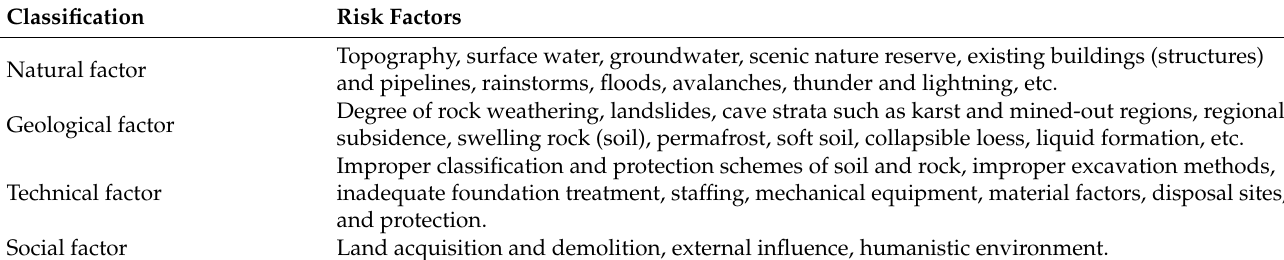
Table 1. Construction safety risk factors based on technical